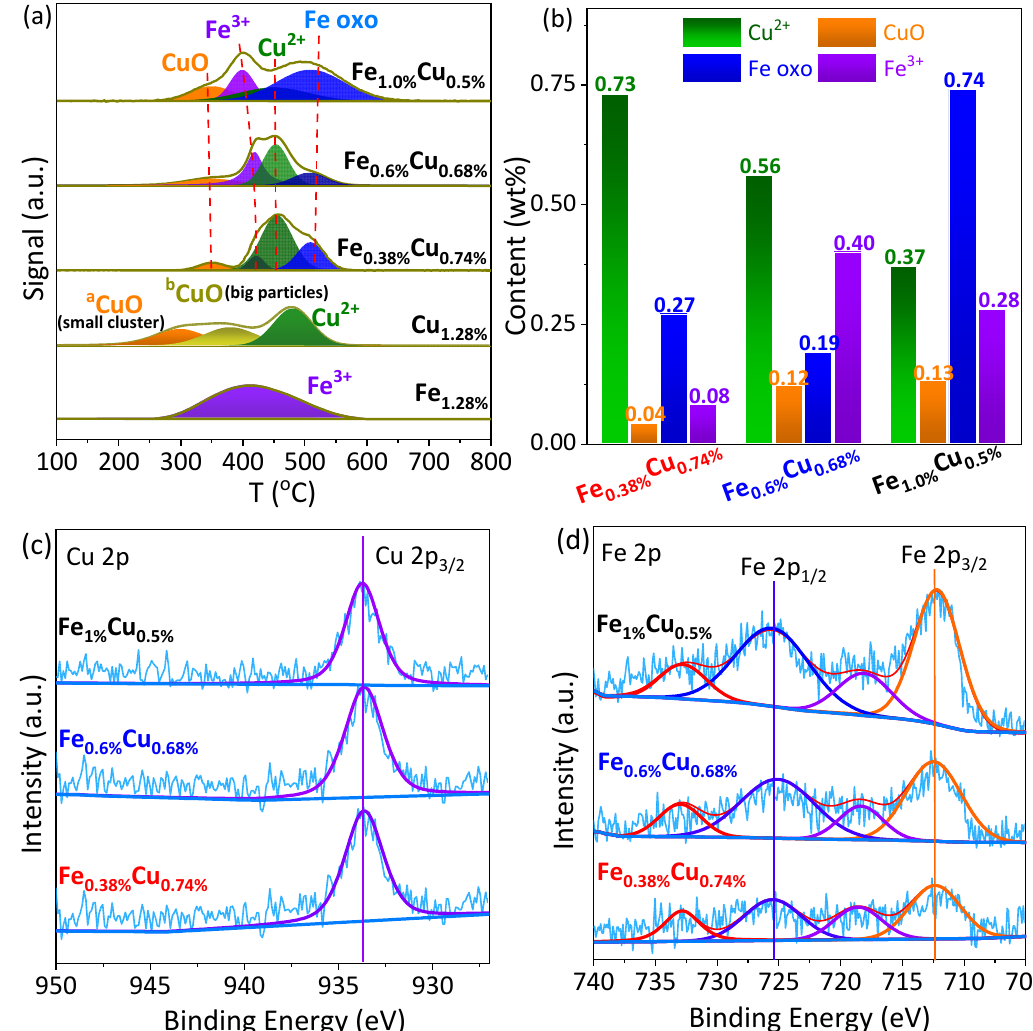
Figure 1. ( a ) H 2 -TPR profiles of the investigated Fe n Cu m -BEA samples; ( b ) Fe, Cu species quantification based on the H 2 consumption of H 2 -TPR; XPS of Cu 2p; ( c ) and Fe 2p; ( d ) of the Fe n Cu m -BEA samples.